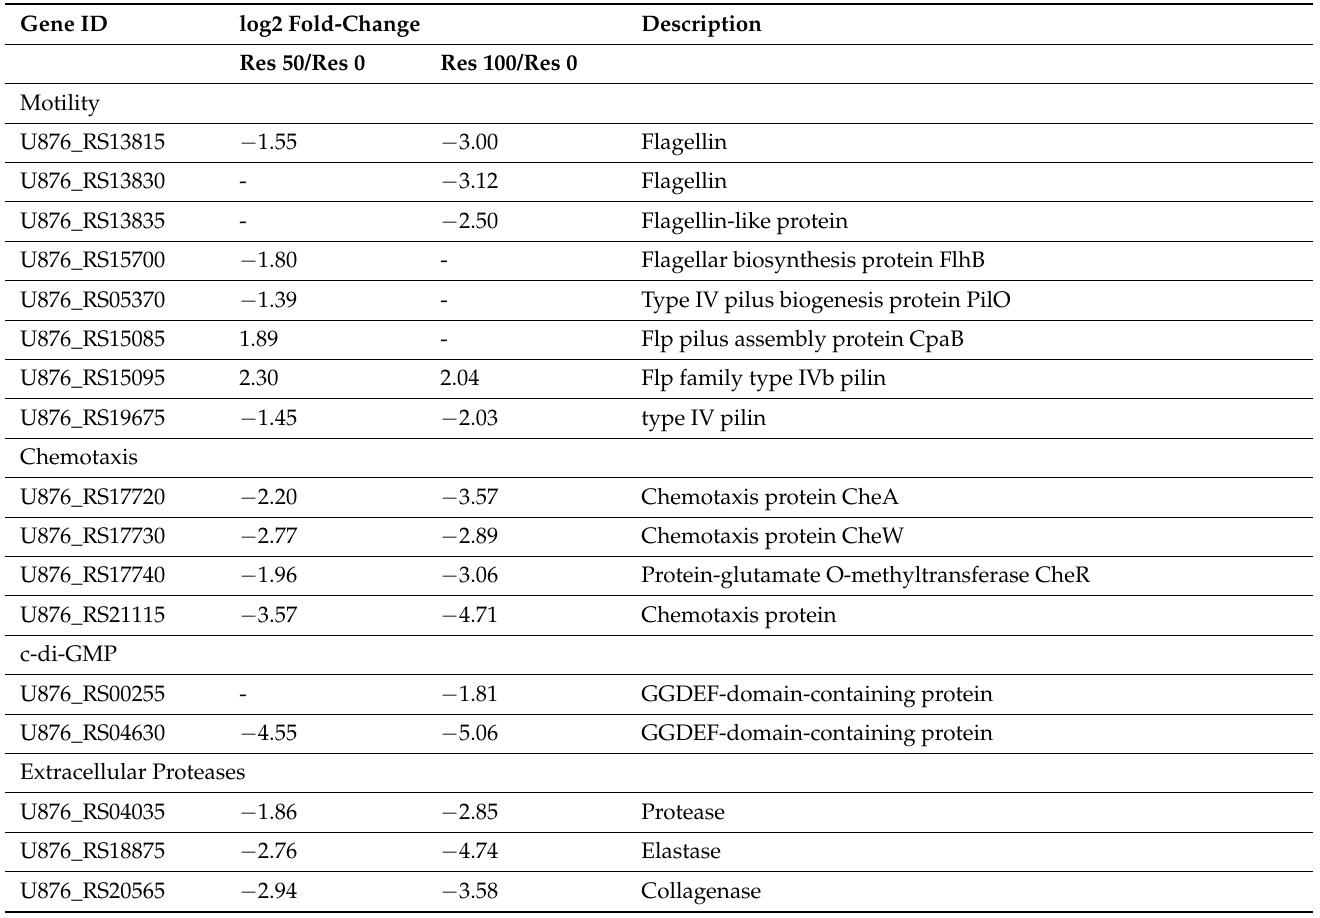
Table 1. A list of some of the important differentially expressed genes between the resveratrol-treated and untreated A. hydrophila NJ-35, including genes related to motility, biofilm formation and other virulence